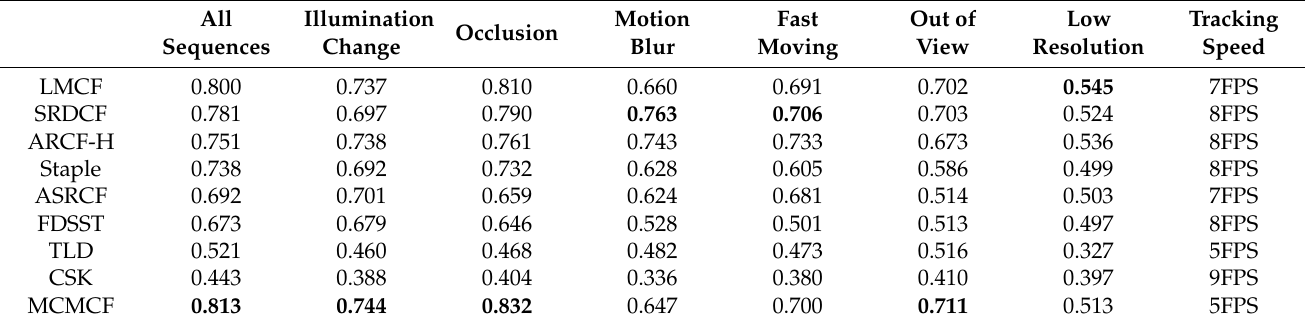
Table 1. Comparison of the success and tracking speed of different tracking algorithms based on the OTB2015